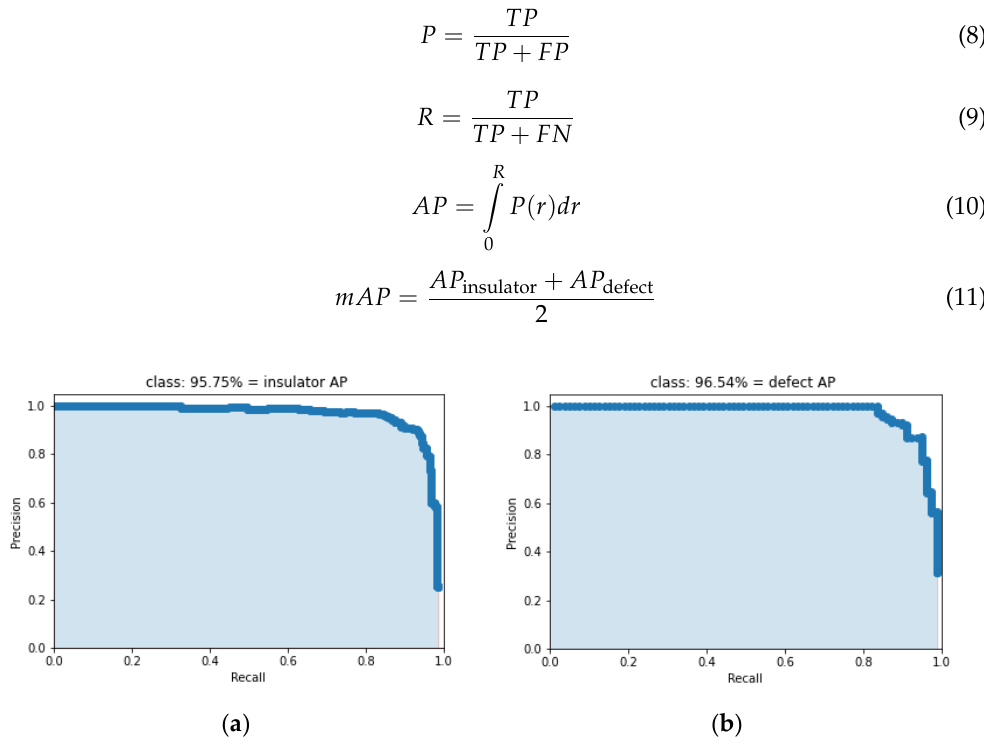
Figure 10. ( a ) Insulator P-R curve diagram; ( b ) defect P-R curve diagram.